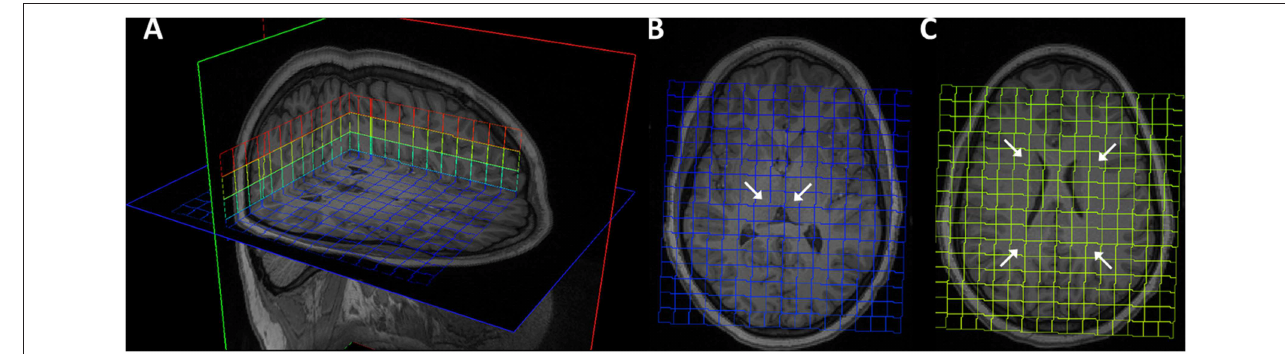
FIGURE 1 | Magnetic resonance spectroscopy excitation grid overlaying T1 MPRAGE images of representative brain. (A) 3D visualization. (B) Bilateral thalamus ROIs indicated by arrows on transverse slice. (C) Bilateral frontal and parietal